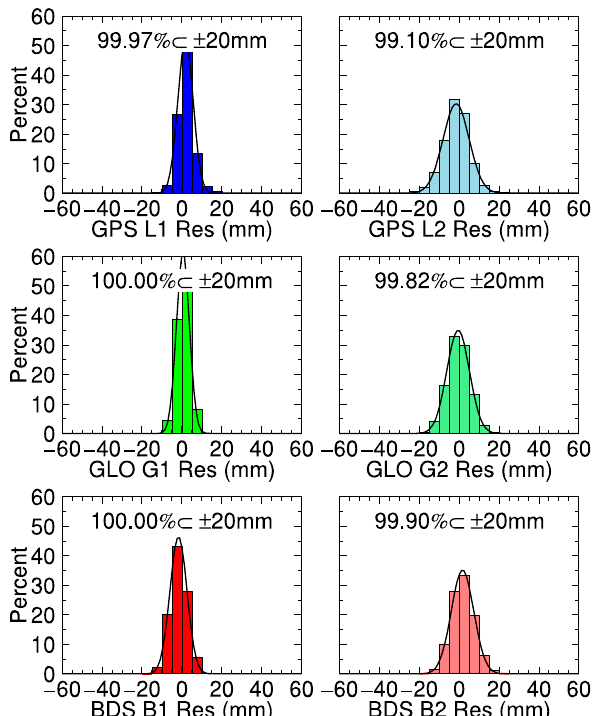
Figure 13. Distribution histograms of the residuals after data processing for the UAV flying trial.